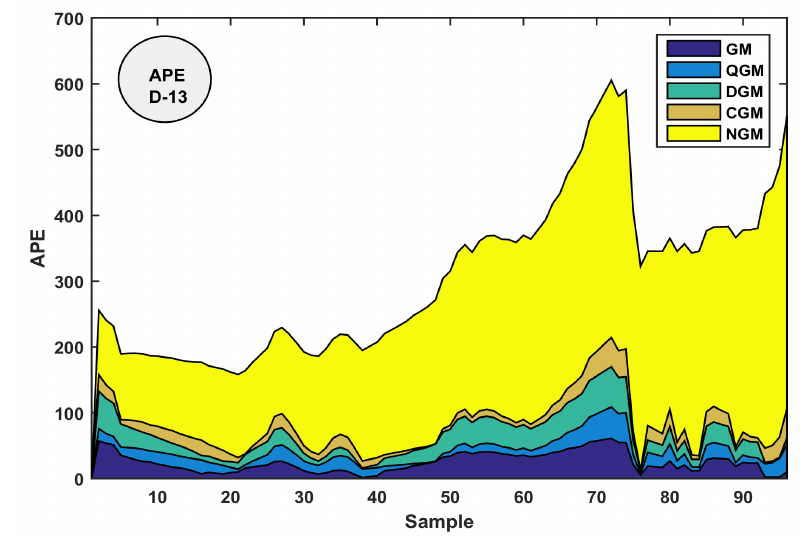
Figure 5. APE of simulated results for D-13. Table 4. Box plot statistics of APE (signal